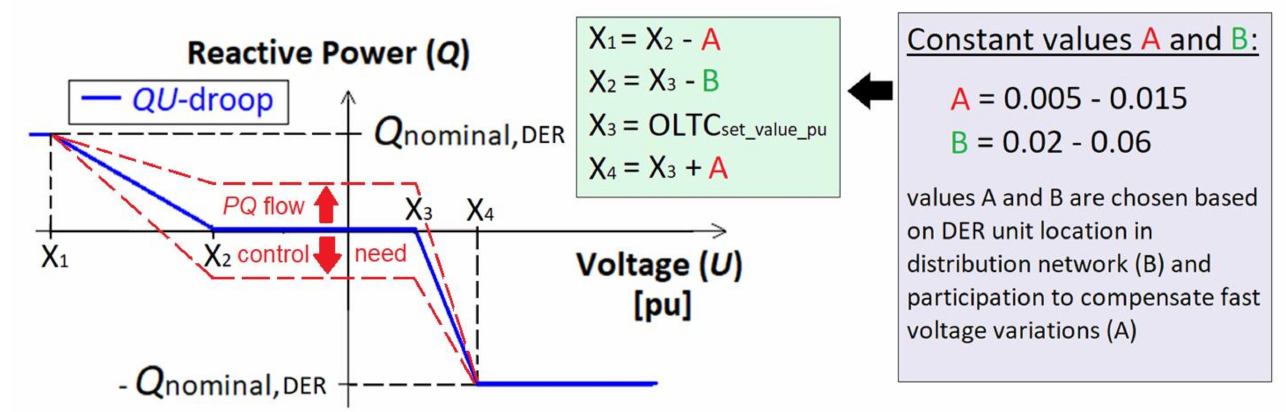
Figure 5. Real-time adaptive DER unit QU -droop based on OLTC set value, OLTC setting value, location, and participation on rapid voltage control, as well as participation on PQ flow management (see Figure 4 and Tables 3 and